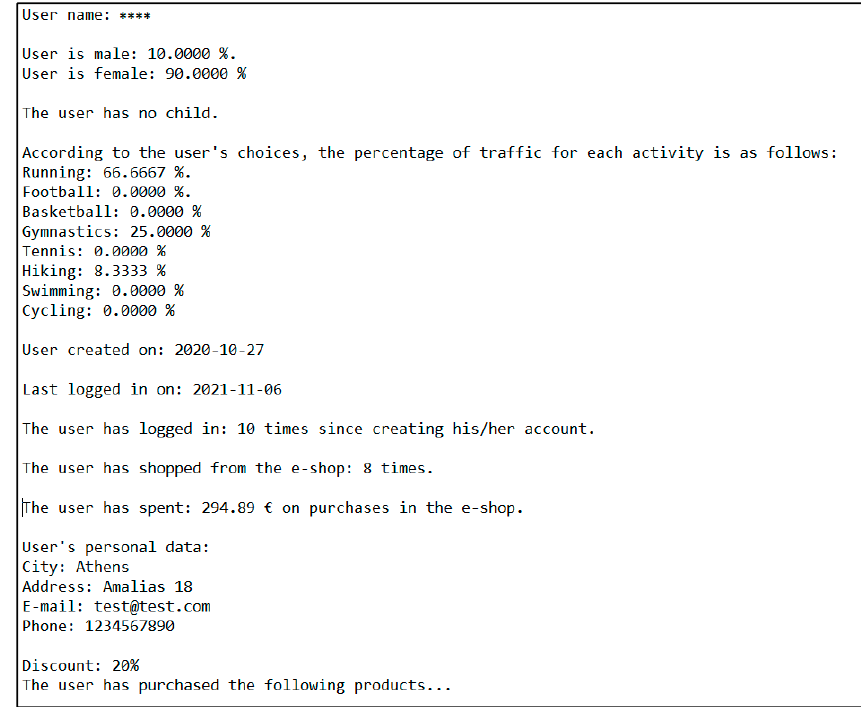
Figure 5. Data analysis and display technique of a user.